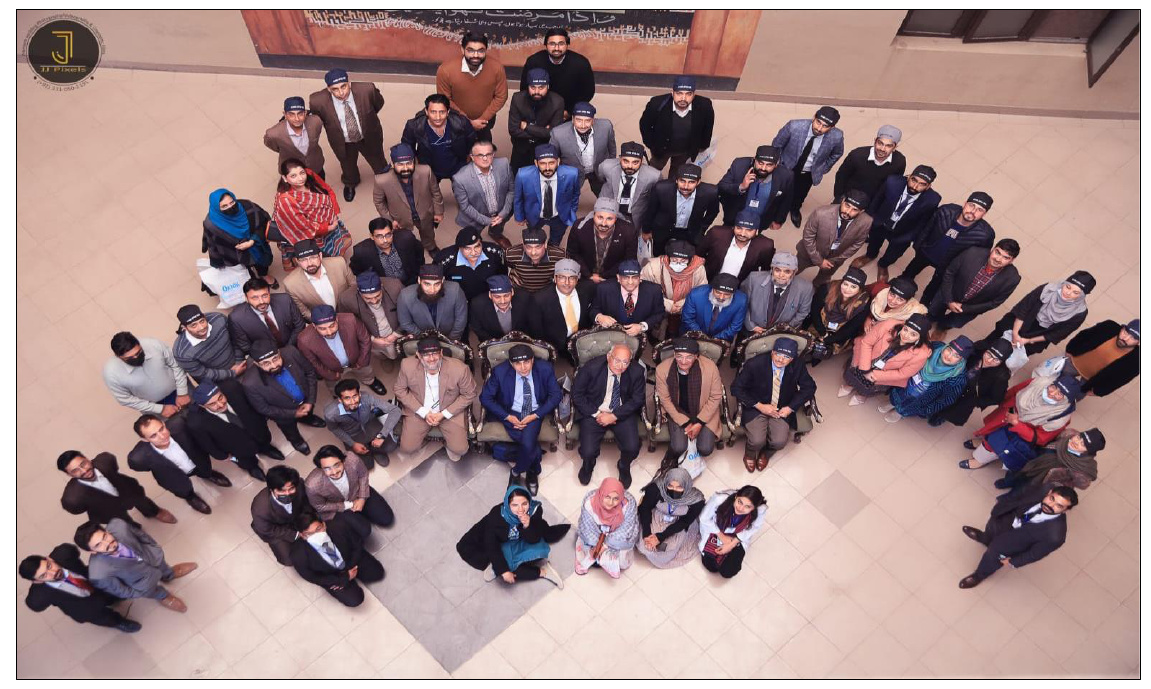
Figure 2: Participants of the symposium on Neonate as a Surgical Patient